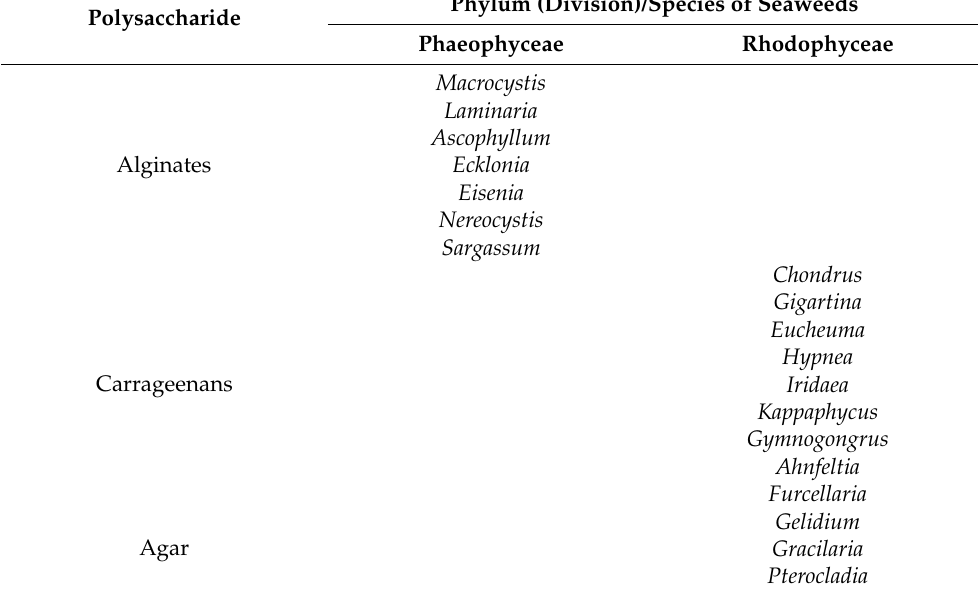
Table 1. Occurrence of polysaccharides in marine algae